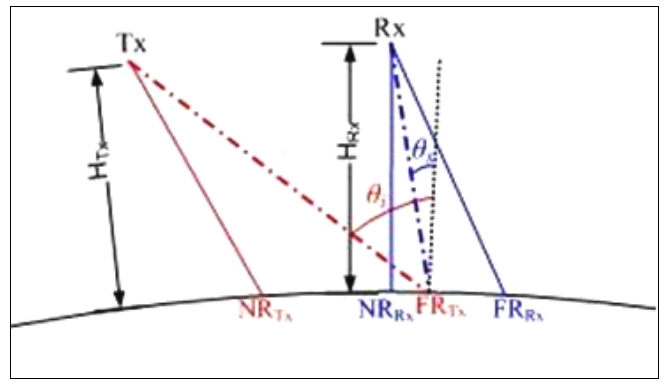
Figure 4. Bistatic observation geometry at the initial time in terms of zenith incidence (  ) angles, receiver (Rx) and transmitter (Tx) near range (NR) and far range and scattering (  s (FR) points, and heights ( H ) of the satellites.